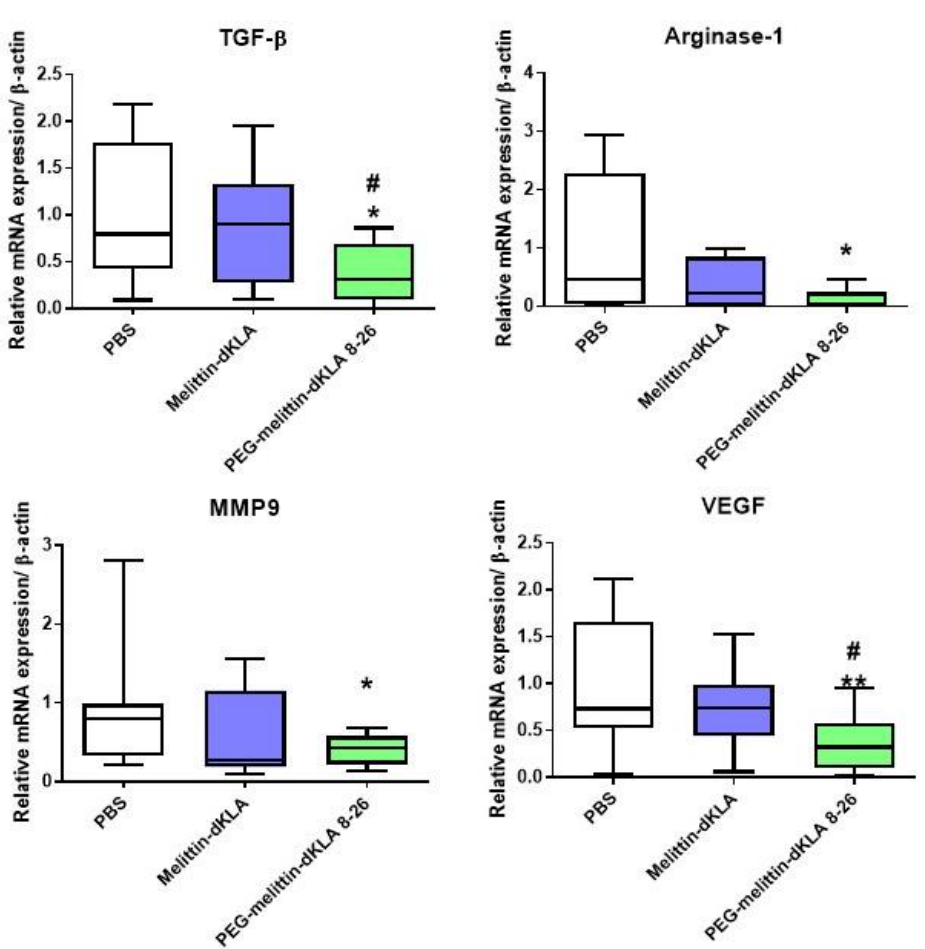
Figure 7. Reduction in M2-like TAMs by PEG-melittin-dKLA 8-26 in the 4T1 TNBC mouse model. Mice were euthanized on day 29 after tumor inoculation, and mouse tumor tissues were harvested. RNA was extracted from tumor tissues. Expression of TGF- β, arginase 1, MMP9, and VEGF was measured using RT-PCR. All data are presented as the mean ± SEM; * p < 0.05, ** p < 0.01 versus the PBS group; # p < 0.05 versus the melittin-dKLA group (n = 10 – 13).